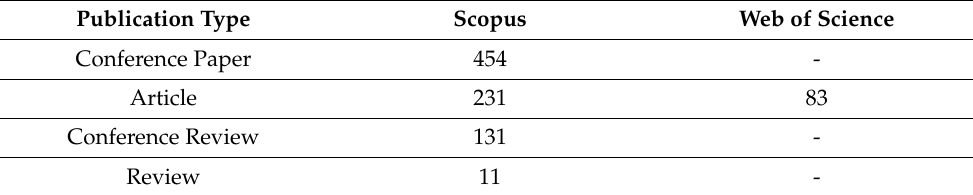
Table 6. Publication types on the Scopus and Web of Science databases on Text-based Emotion